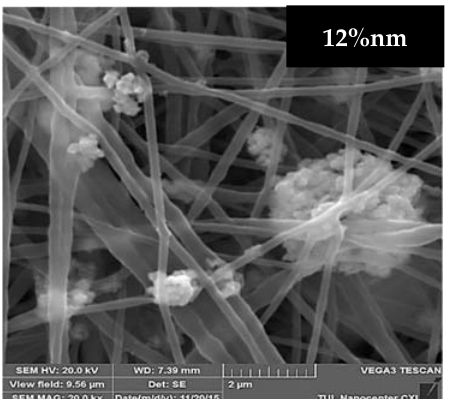
Figure 4. SEM images (20,000x magnification) of composite nanofibers produced from both elec- trodes with different concentrations of nanoparticles of CuO.